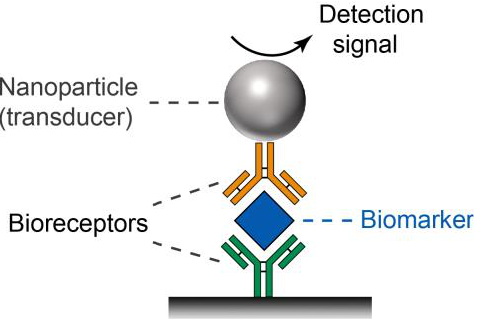
Figure 1. Schematics showing the principle of a typical POC nanobiosensor.